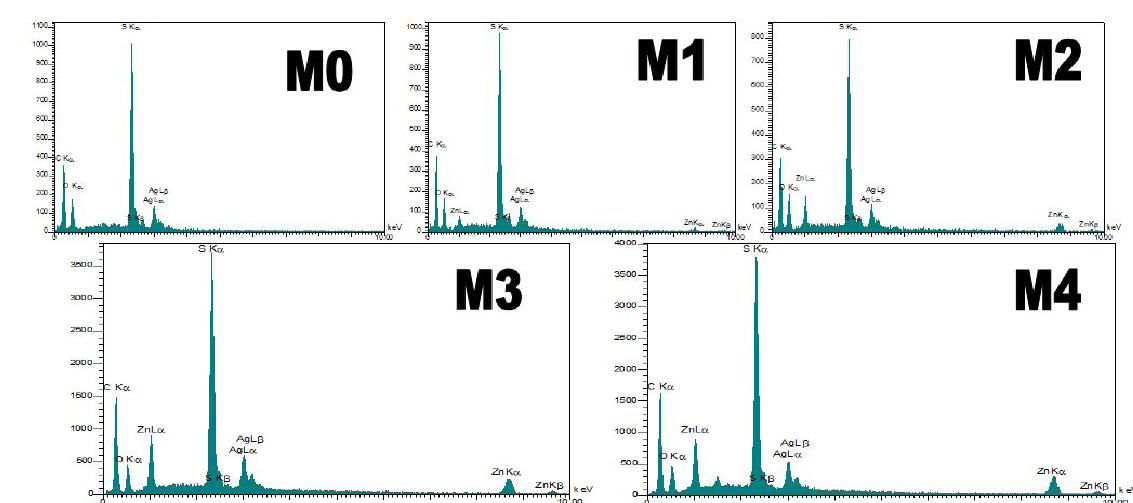
Figure 5. Energy-dispersive X-ray spectroscopy of the synthesized membranes